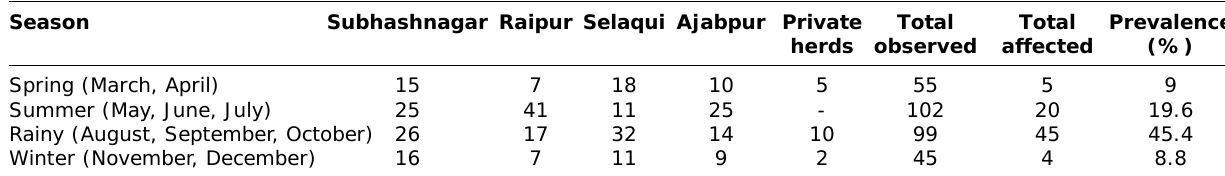
Figure-4. Agarose gel electrophoresis of amplified DNA (1098 bp) by using Theileria specific primer set